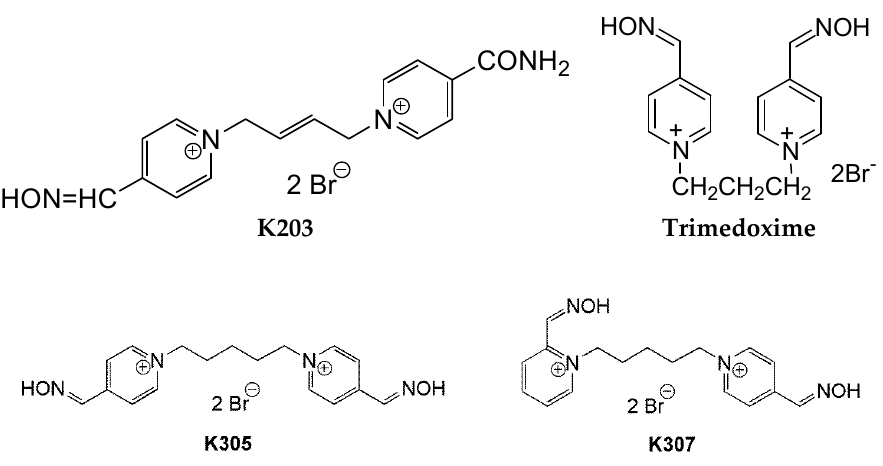
Figure 1. Chemical structures of the studied oximes.